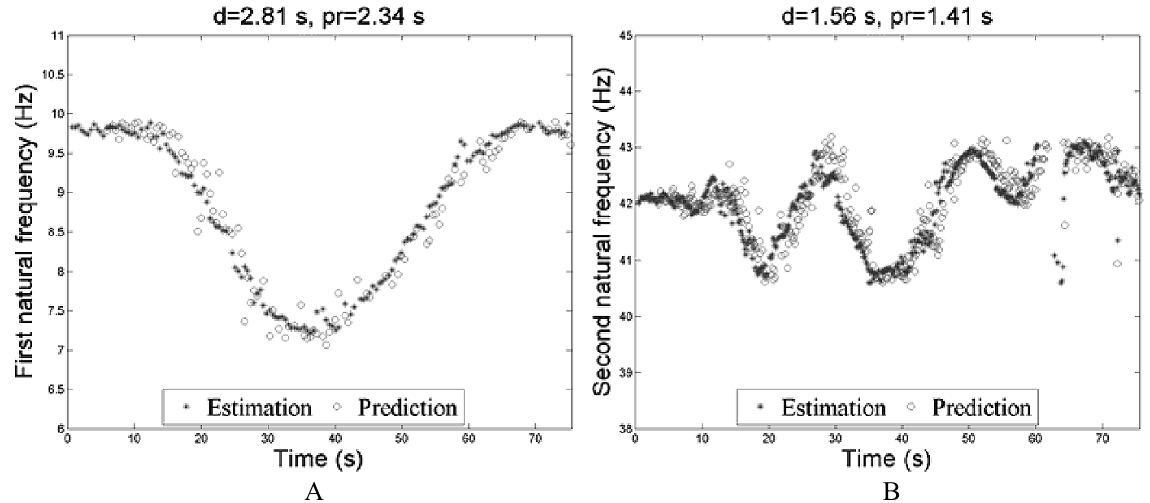
Fig. 5. Comparison between estimation and prediction. A: first frequency. B: second